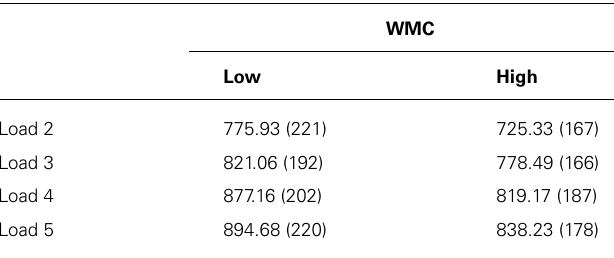
Table 1 |Averaged median reaction times (ms) in each memory load of the Sternberg task for low and highWMC